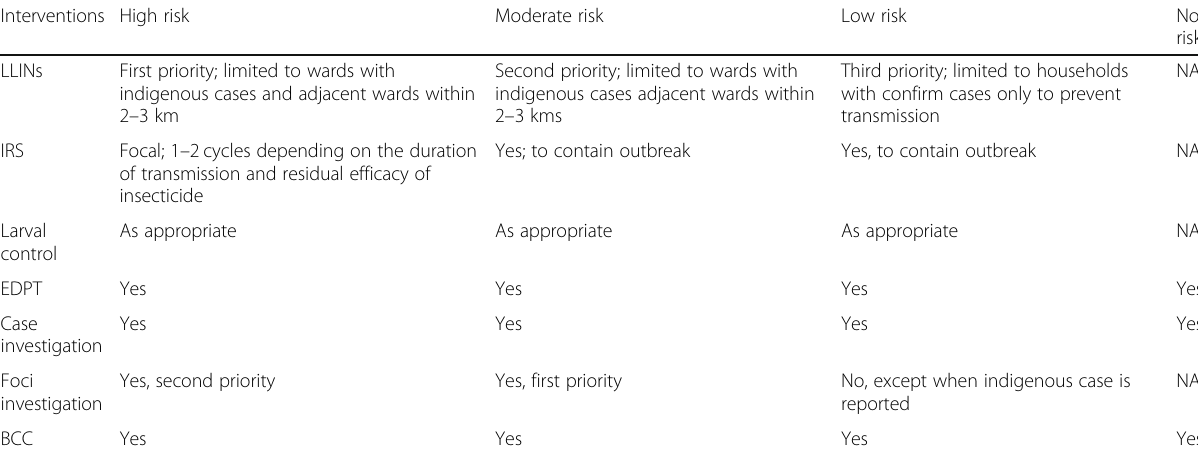
Table 4 Recommended interventions per stratum for Nepal malaria program Interventions High risk Moderate risk Low risk No